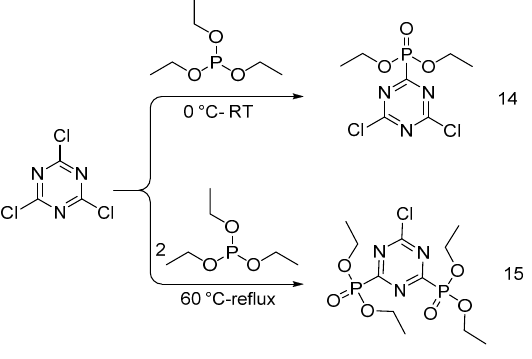
Figure 10. Representative synthesis of monomers ( 14 ) and ( 15 ) via Michaelis-Arbuzov reaction.